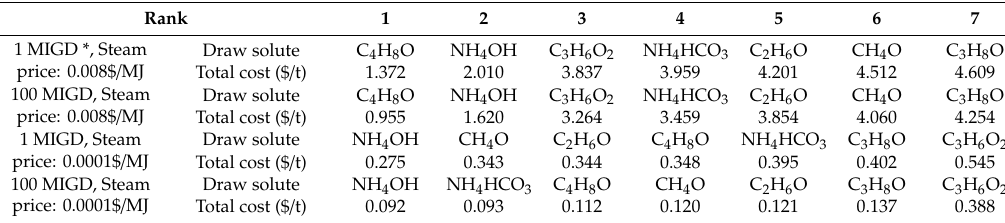
Table 2. Ranks and total costs to produce a ton of product water. Reprinted Table with permission from [32]. Copyright (2012)